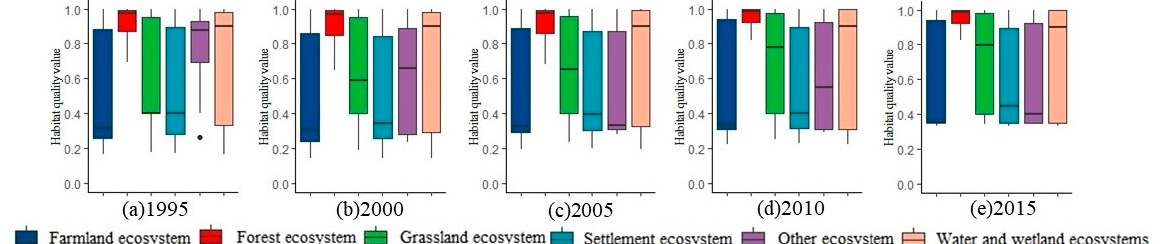
Figure 7. Numerical distribution of habitat quality for different ecosystem types: ( a ) 1995; ( b ) 2000; ( c ) 2005; ( d ) 2010; ( e ) 2015.